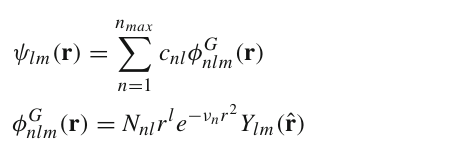
where N nl is the normalization constant,